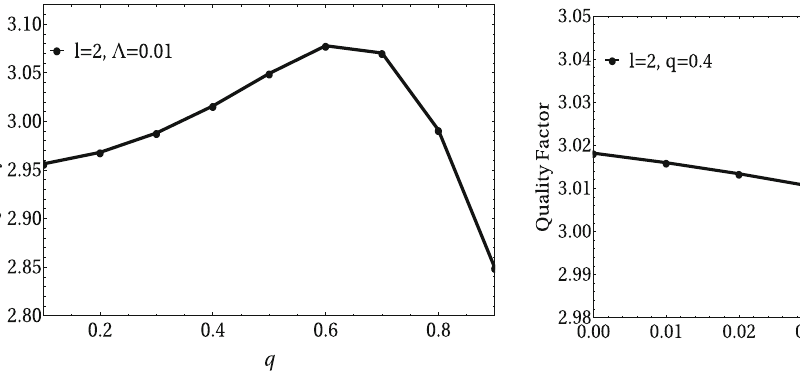
Fig. 3 Q-Factor vs magnetic charge q and cosmological constant (cid:2)